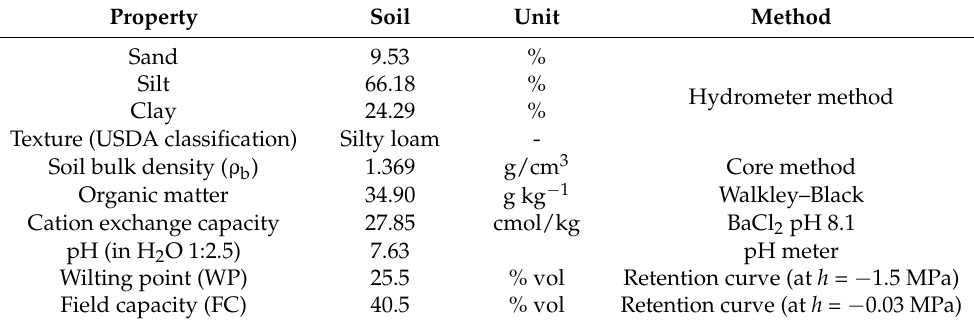
Table 1. Main physicochemical properties of the investigated